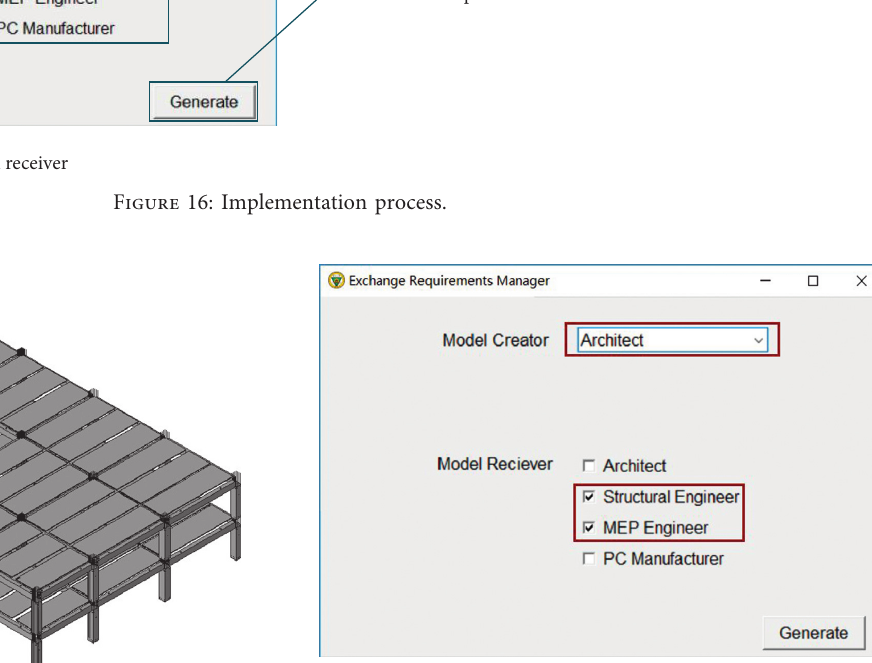
Figure 18: Select involved